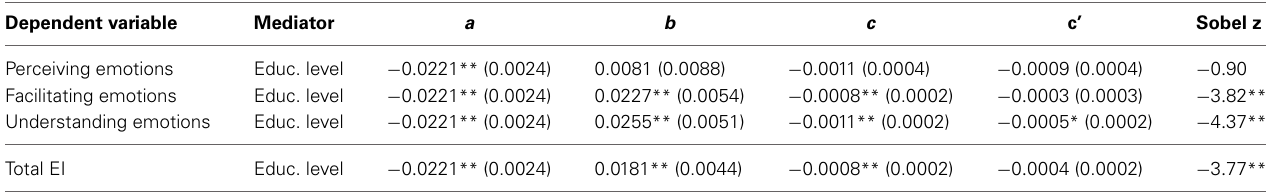
Table 3 | Educational level as mediator of the relationship between age and EI*.